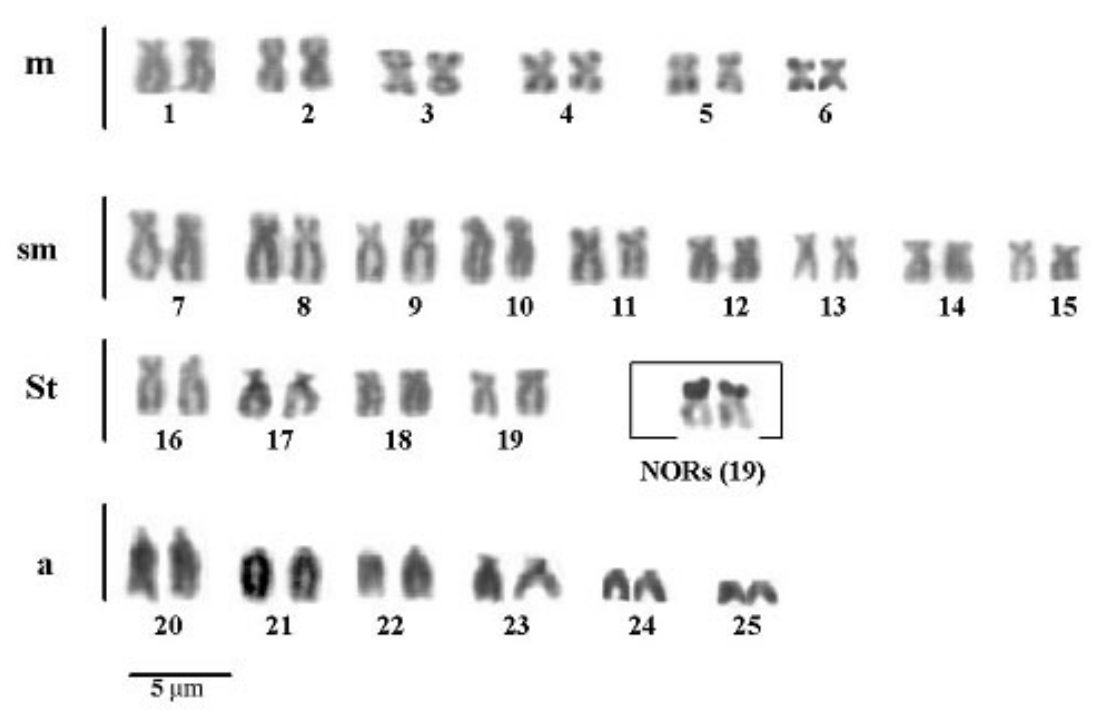
F IGURE 2.- Giemsa-stained karyotype of Alburnus filippii . The NOR-bearing chromosome pair, after silver staining, is shown in the box. = 5